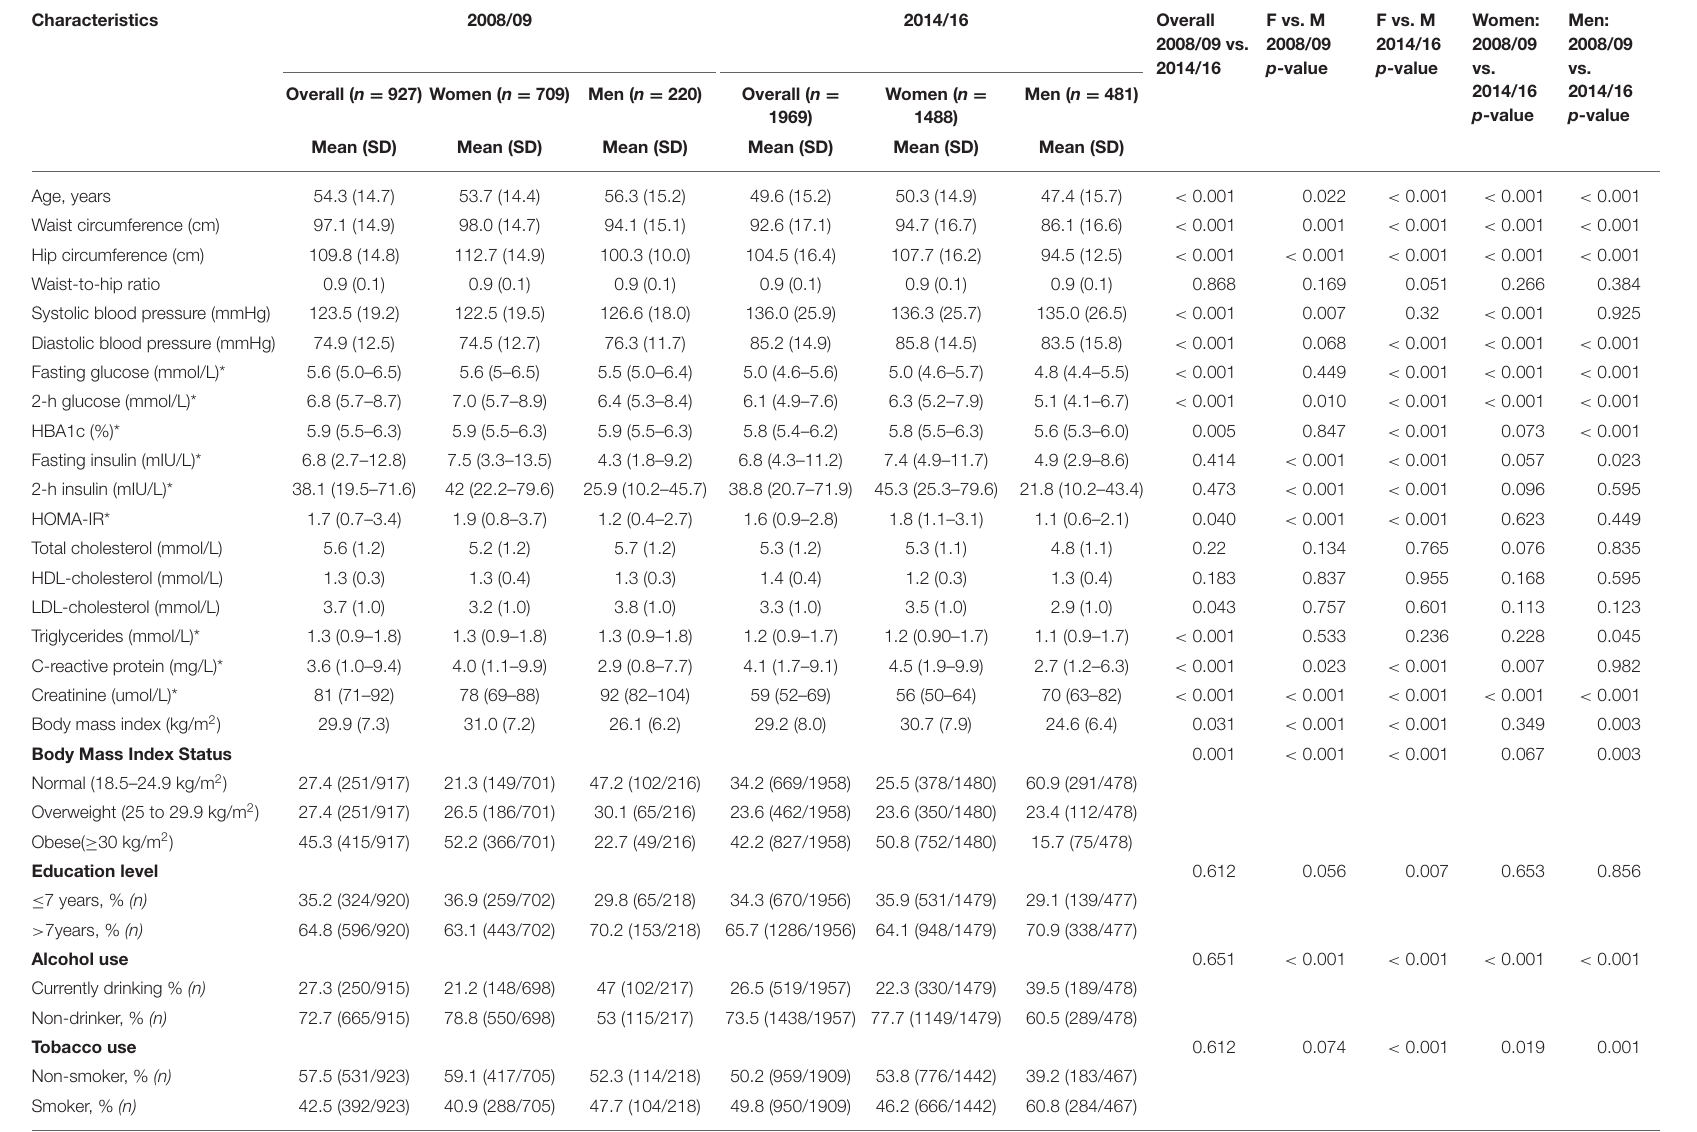
TABLE 1 | Comparison of the characteristics in 2008/09 and 2014/16 by gender.